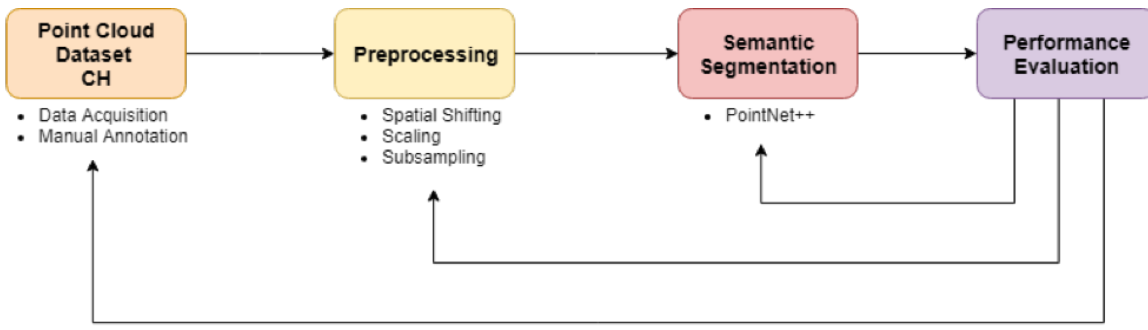
Figure 1. Workflow with the four main steps of semantic segmentation procedure.